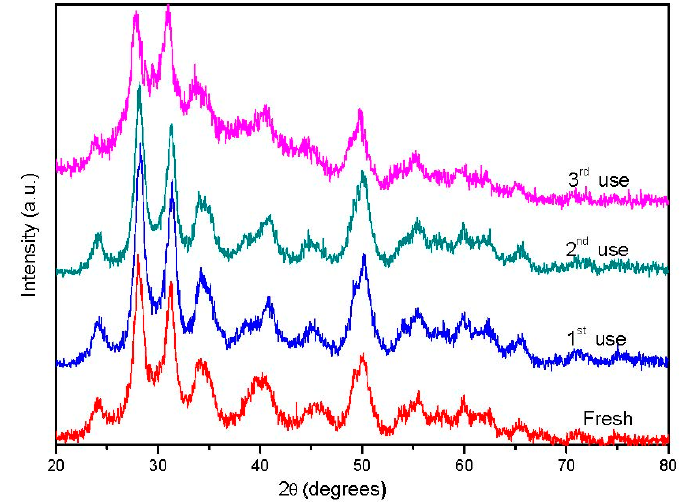
Figure 10. XRD patterns obtained for the Pt//W/ZrO 2 catalyst in the reusability test.